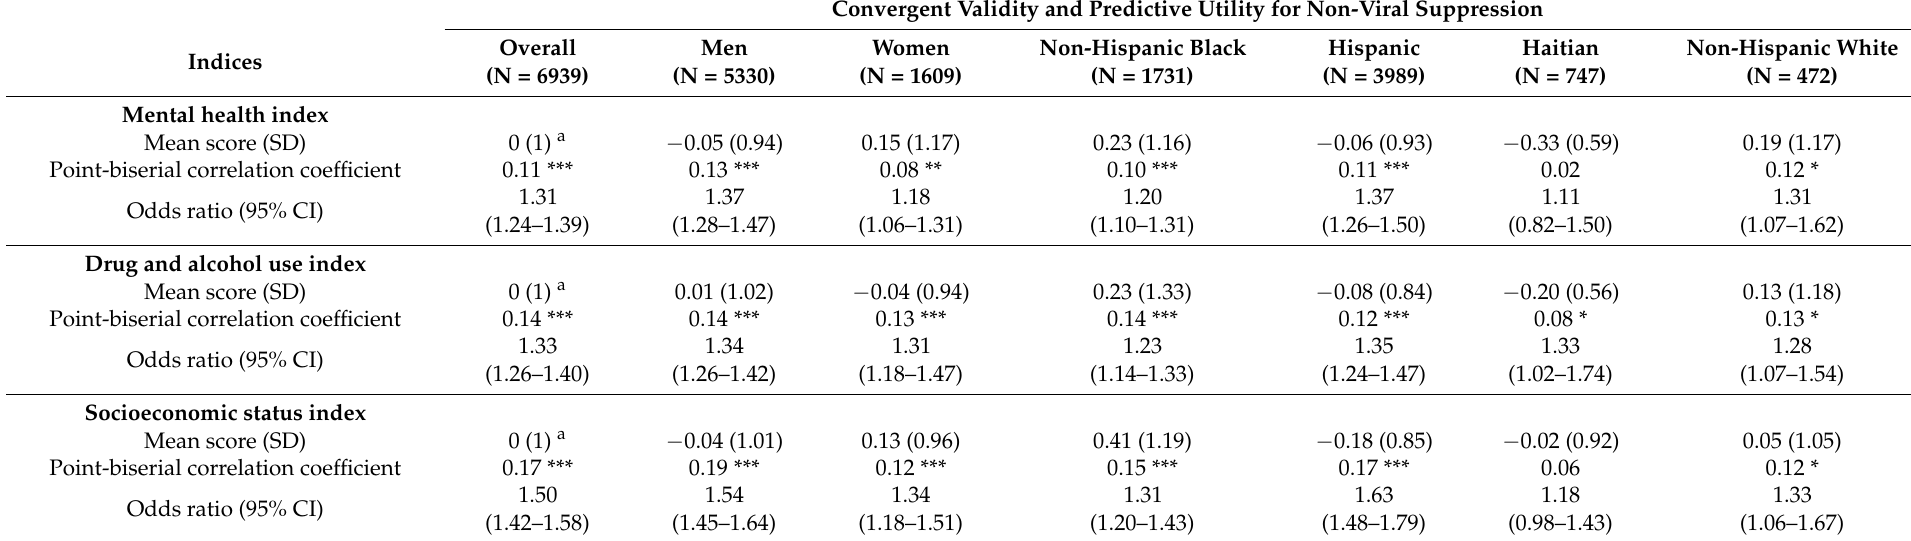
Table 2. Range of scores, and convergent validity and predictive utility for non-viral suppression of overall vulnerable/enabling indices for the Miami–Dade County Ryan White Program client